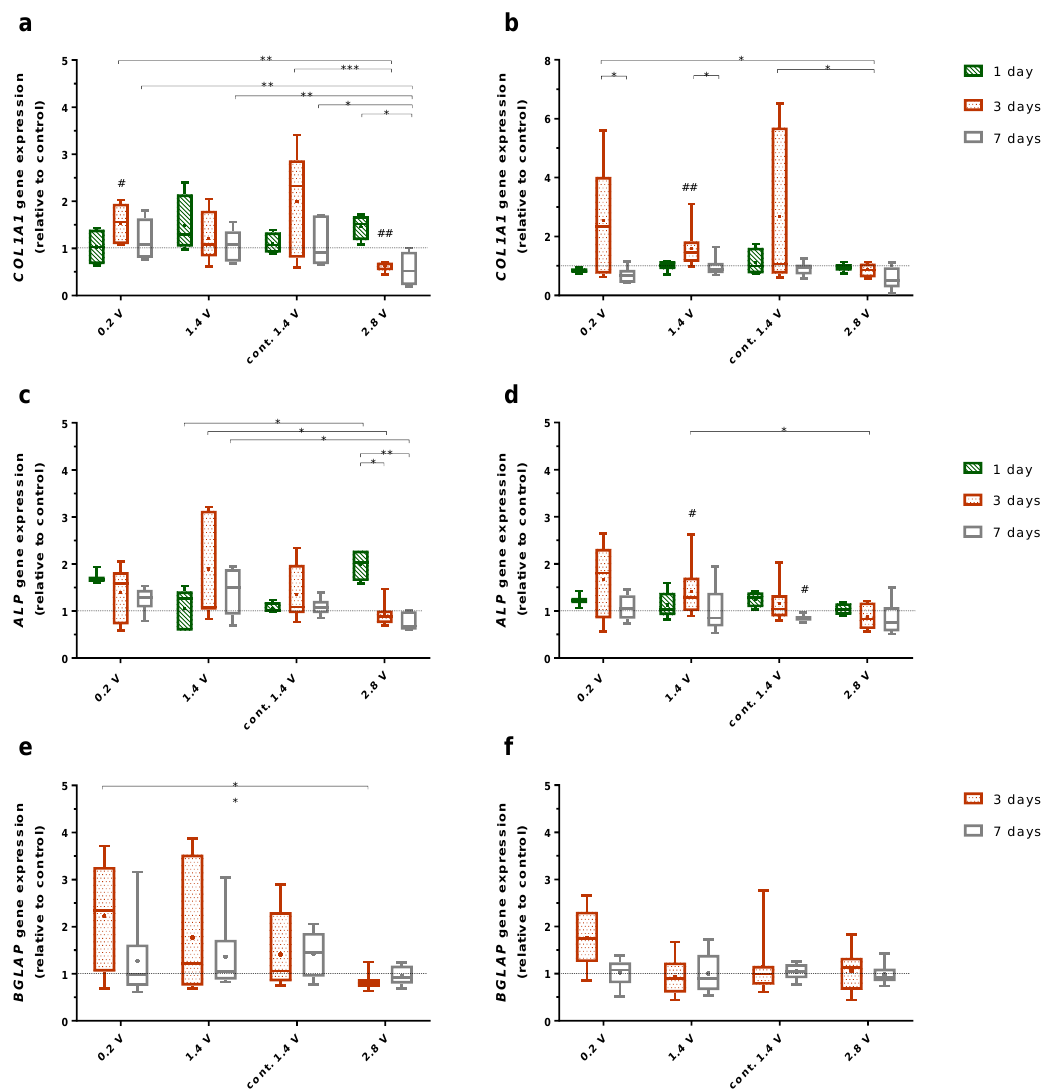
Figure 3. 2 − ∆∆ Ct values for the gene expression of collagen type I ( COL1A1 ; a , b ), alkaline phosphatase ( ALP ; c , d ), and osteocalcin ( BGLAP ; e , f ) after electrical stimulation, compared to the unstimulated controls for the same time points. Cells were cultured on Ti6Al4V electrodes ( a , c , d ) and collagen-coated coverslips ( b , d , f ) for one, three, and seven days. The 0.2V, 1.4 V, and 2.8 Vgroups were stimulated 3 × 45 min per day, while the cont. 1.4 Vgroup was stimulated continuously with 1.4 V. # indicates significant di ff erences between the stimulated and control groups: # p < 0.05 and ## p < 0.01 (Wilcoxon matched pair test), * indicates significant di ff erences between stimulation groups: * p < 0.05, ** p < 0.01, *** p < 0.001 (two-way ANOVA). n ≥ 3.